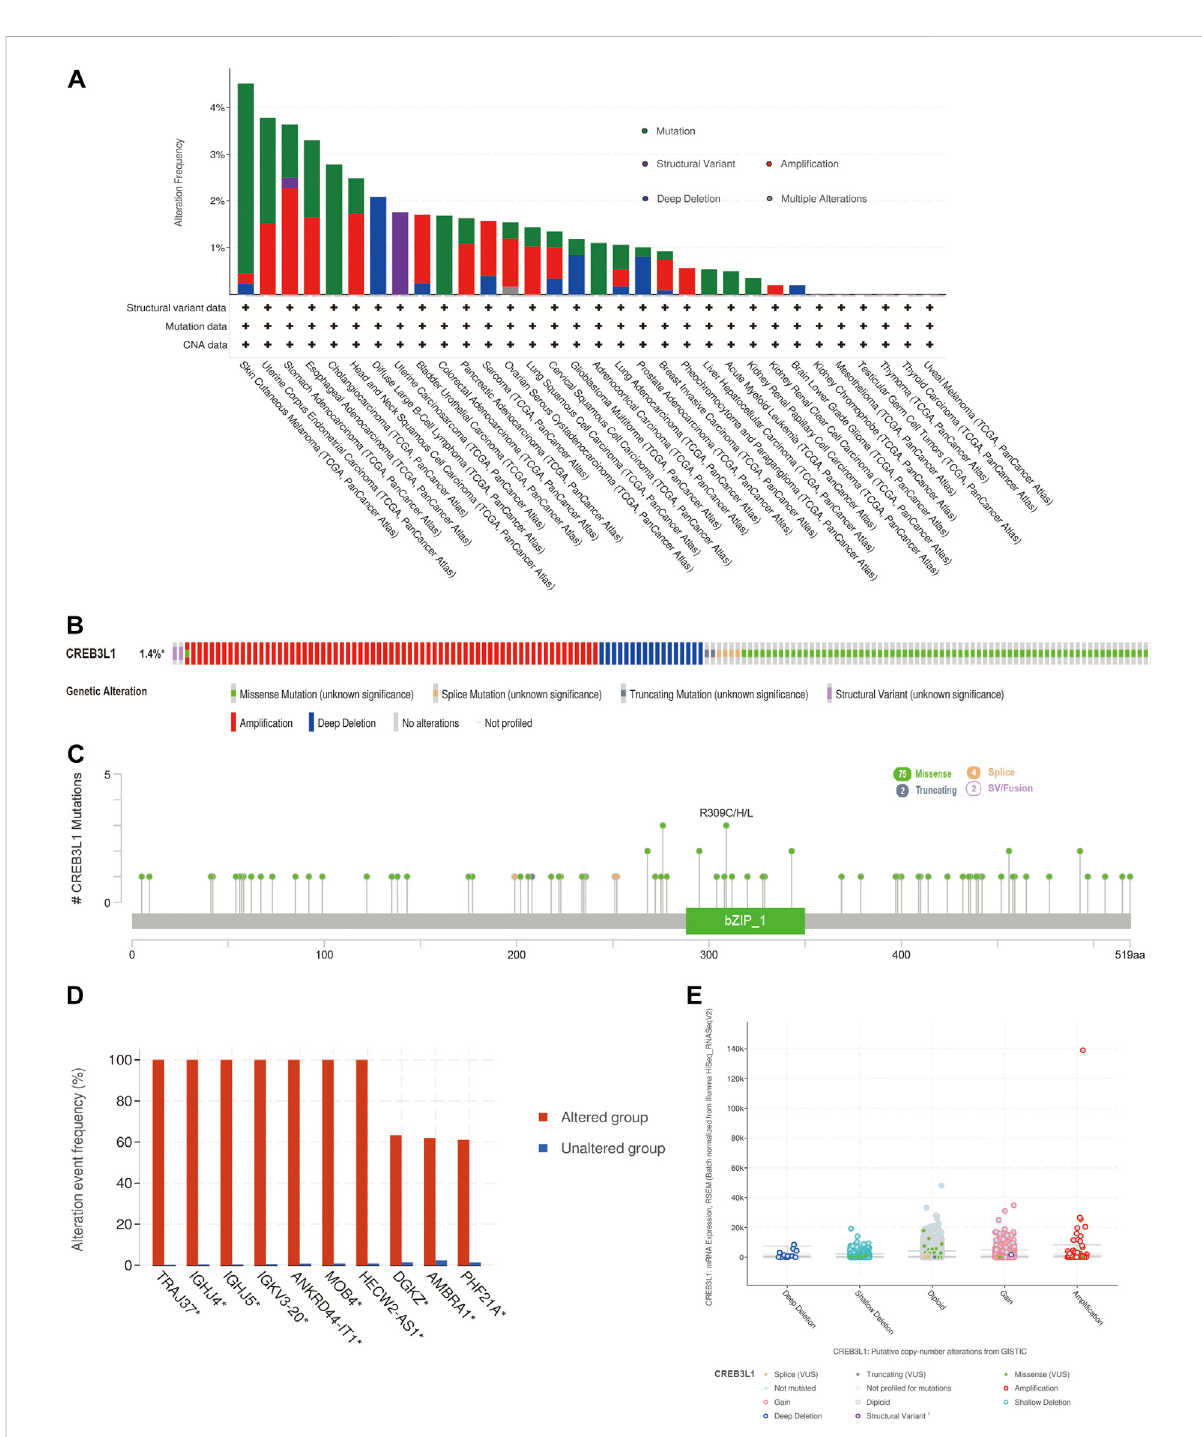
FIGURE 2 The genetic alteration characteristics of CREB3L1 in pan-cancer. (A) The alteration frequency of CREB3L1 with different types of mutations in various cancer types. (B) Summary of different genetic alteration types of CREB3L1 (Different colors refers to different types of CREB3L1 genetic alterations). (C) The mutation types, sites, and sample numbers of the CREB3L1 genetic alterations. (D) Co-occurrence of genetic mutations in tumors with CREB3L1 alterations. (E) The correlated alteration types and putative copy-number of CREB3L1 in pan-cancer. * Altered